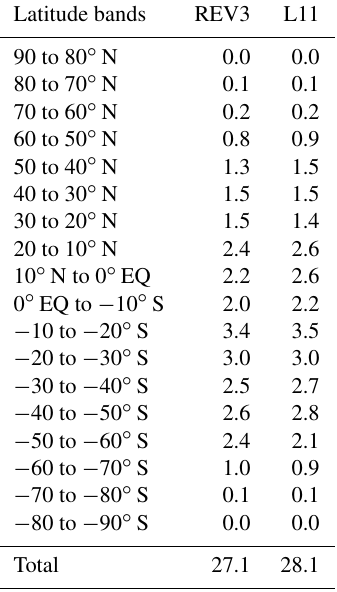
Table 2. Annual DMS flux (TgSyr − 1 ) per 10 ◦ latitudinal band obtained from DMS-Rev3 is given in the table along with the annual DMS flux obtained from L11 for